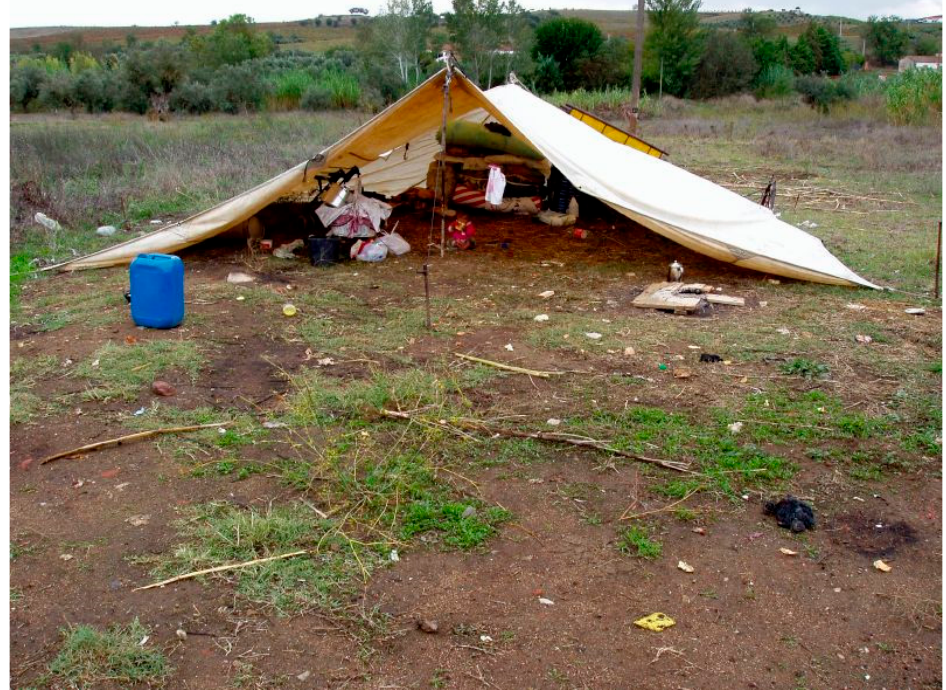
Figure 1. Cigano Camp. Photograph by Fernando Moital. January 2022.